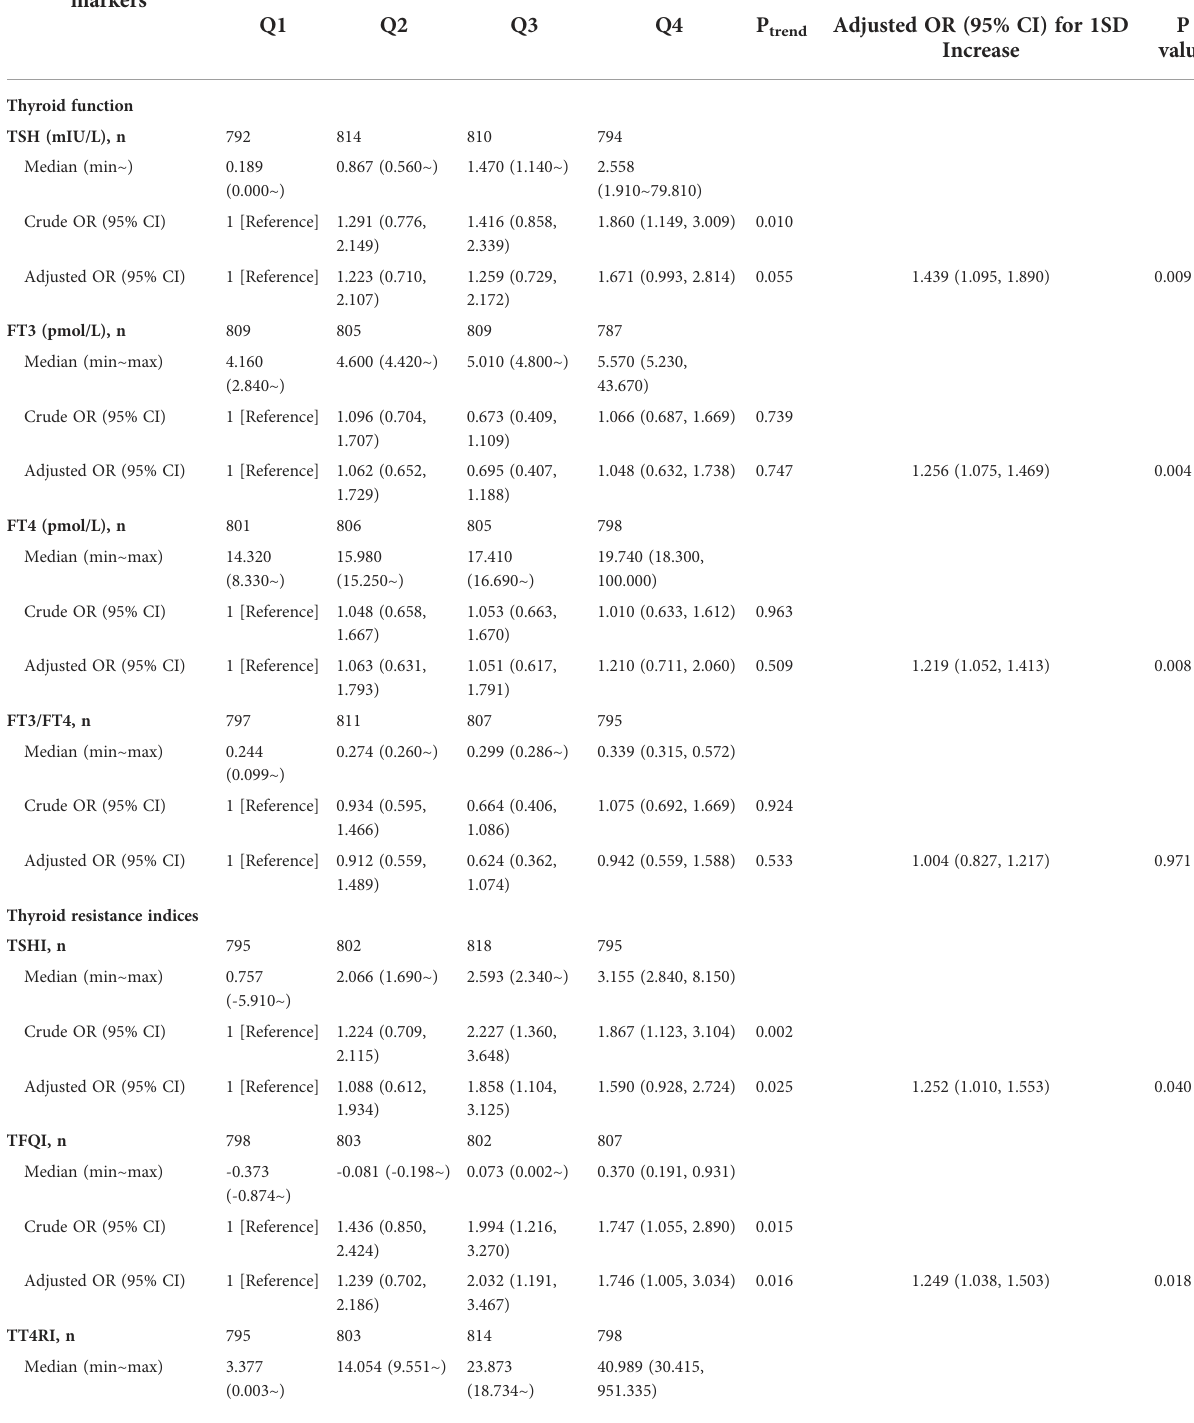
TABLE 3 Odds ratios (ORs) and 95% con fi dence intervals (CIs) of neonatal TSH levels >5 mIU/L by quartiles of maternal thyroid function and thyroid resistance indices, Huizhou mother-infant